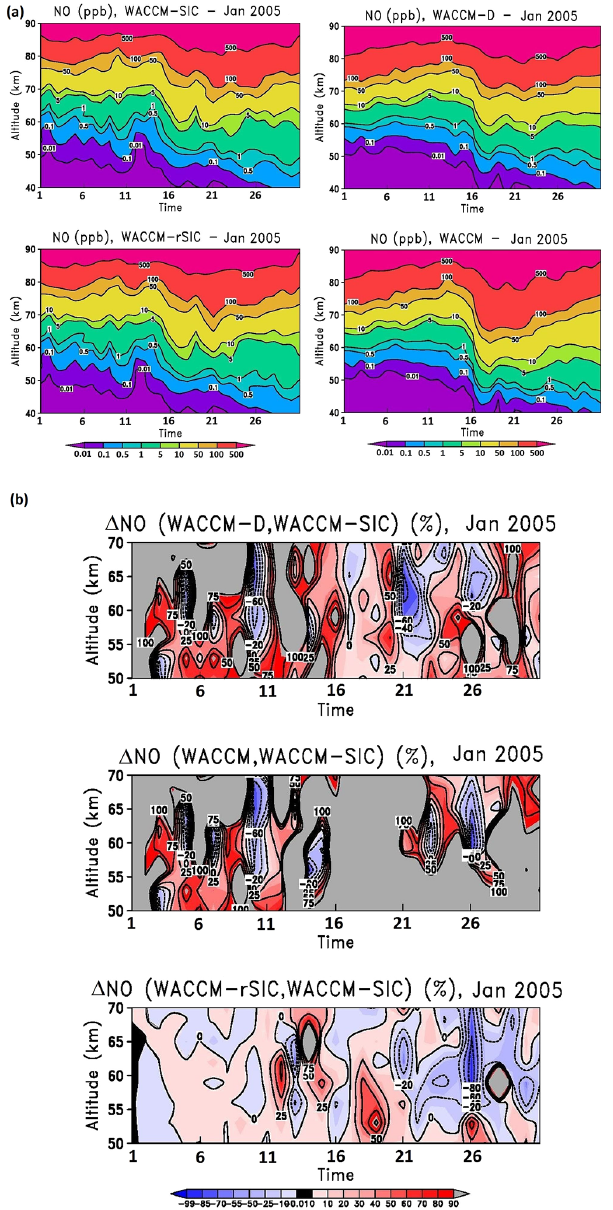
Figure 5. (a) Zonal mean vertical concentration profiles of mesospheric/upper-stratospheric NO 2 (in ppb) for Northern Hemi- sphere polar latitudes (60–90 ◦ N) during January 2005; (b) percent- age difference between three models (WACCM-D, WACCM and WACCM-rSIC) and the full